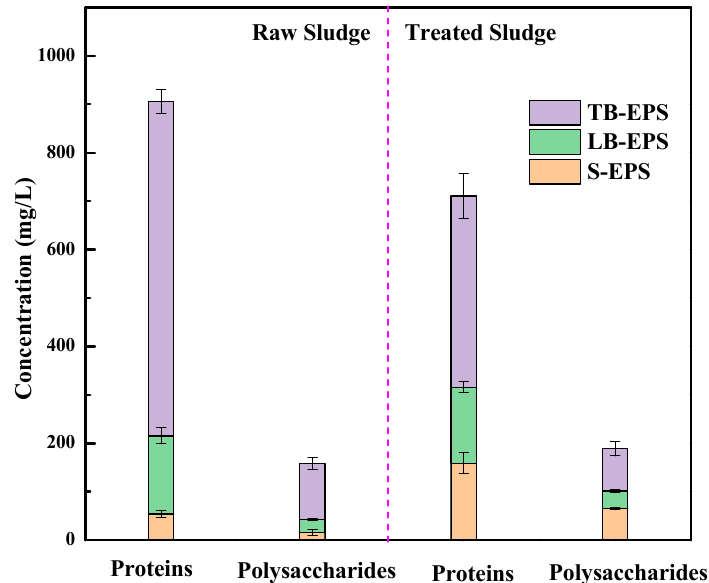
Figure 7. Concentrations of proteins and polysaccharides in different fractions of EPS before and after sludge conditioning. Conditions: Initial pH = 6.8, KIO 4 dose = 1.4 mmol/g VSS, Fe( Ⅱ )/KIO 4 molar ratio = 1.2.